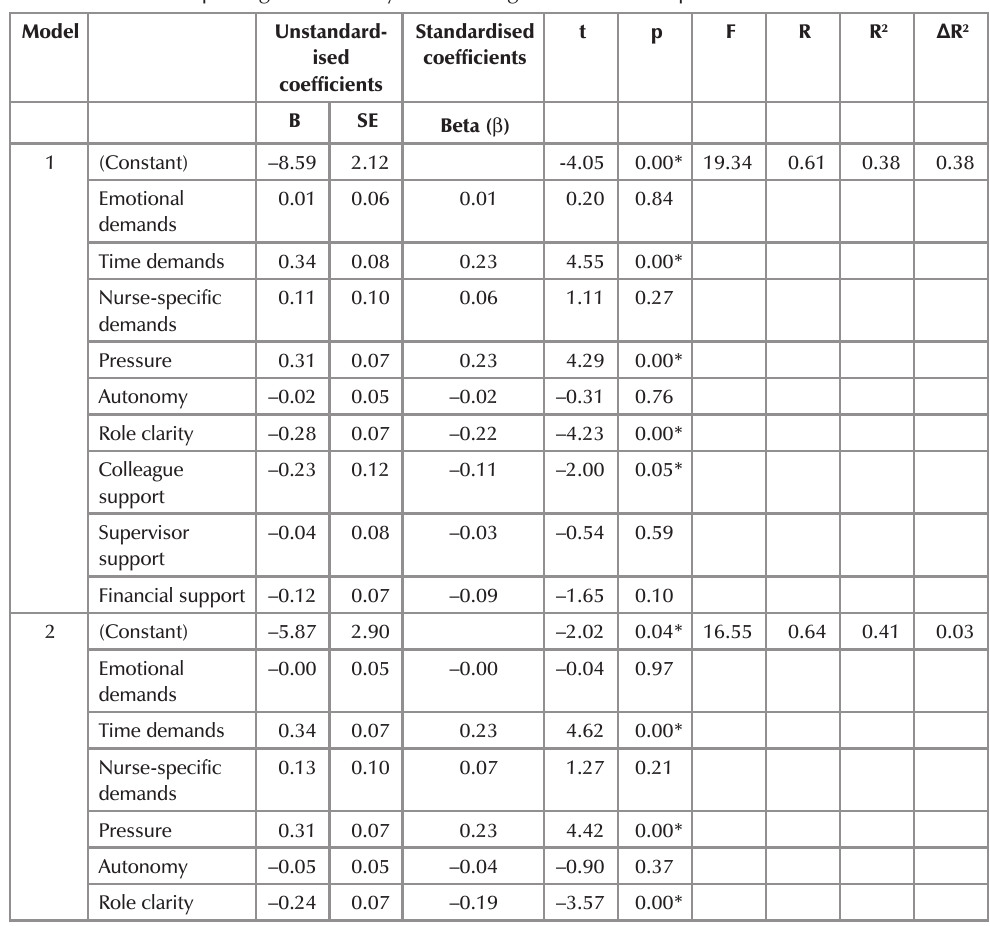
Multiple regression analyses with negative WHI as dependent